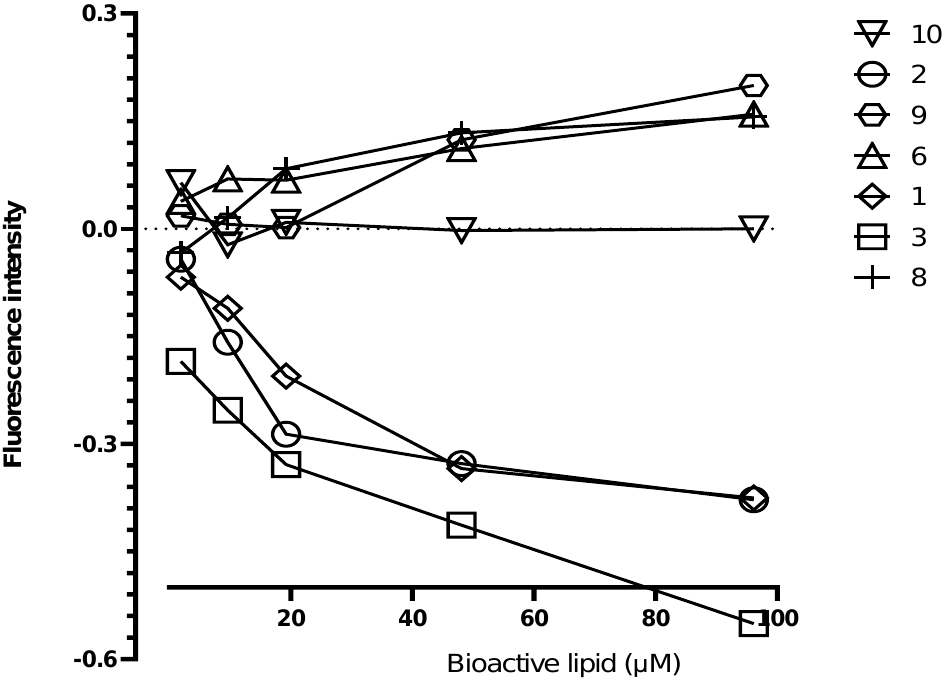
Figure 4. Effect of bioactive lipids on the Trp fluorescence of rePON1. rePON1 (50 µg/mL) was incubated with different bioactive lipids at various concentrations (0, 1, 5, 10, 25, 50, 75, or 100 µg/mL) in Tris buffer (pH 8.4). The fluorescence spectra were measured at an excitation of 290 nm and emission in the 320–340 nm range. Change in fluorescence was calculated as described in Experimental Procedures. Each experiment was repeated separately at least three times. See Figure 1 for compounds corresponding to each number.